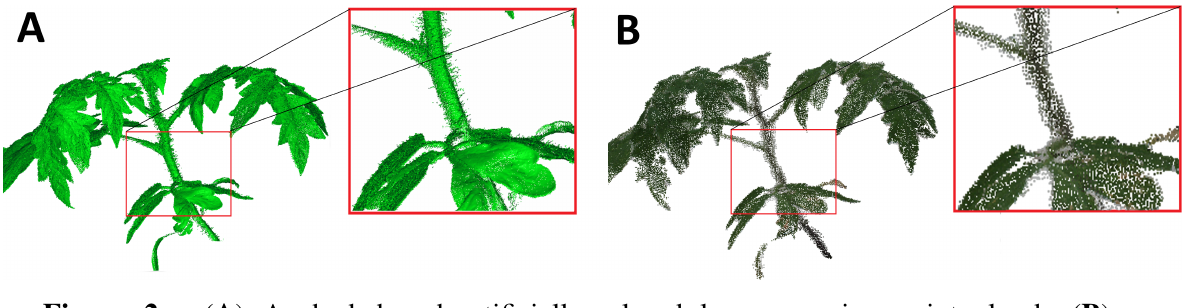
( A ) A shaded and artificially-colored laser scanning point cloud; ( B ) a